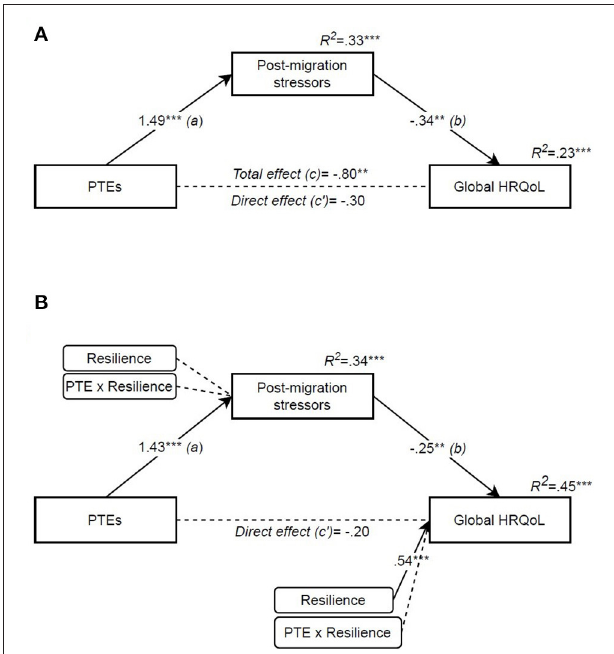
FIGURE 2 | Potentially traumatic events’ effect on Global HRQoL mediated by post-migration stressors and moderated by resilience. (A) Mediation (PROCESS model 4), (B) Moderated mediation (PROCESS model 8). Independent variable: PTE [potentially traumatic events (RTHC)]. Mediator: post-migration stressors (RPMSS). Outcome: global HRQoL [health-related quality of life (KIDSCREEN-10)]. Moderator: resilience (CYRM-12). Covariate: age. All coefficients are unstandardized. * p < 0.05, ** p < 0.01, *** p < 0.001.